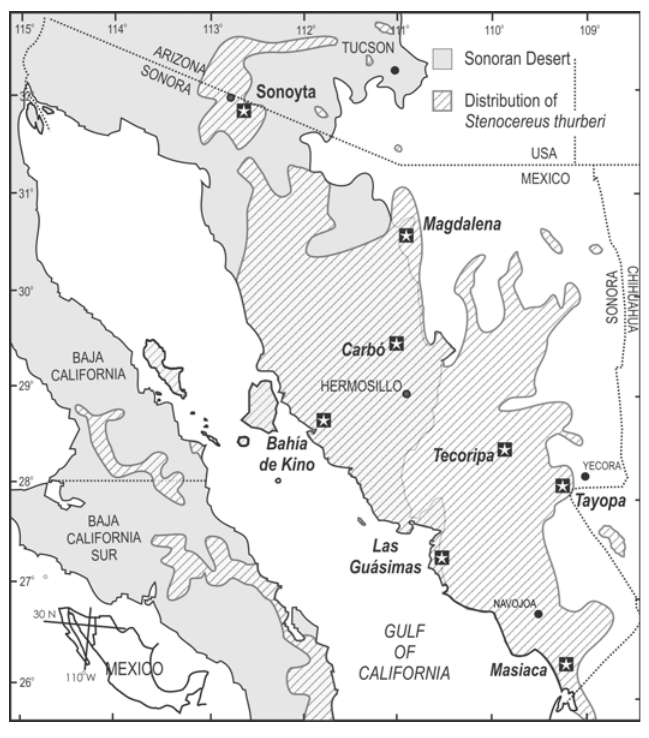
Fig 1. Geographical distribution of Stenocereus thurberi (diagonal lines; modified from Turner et al ., 1995), and location of the eight studied populations (stars). Sonoran Desert extent (gray). doi:10.1371/journal.pone.0152329.g001 were stored in the field in an ice chest. Later that day, these were transferred to a freezer at -19°C before storing in an ultracold freezer (-80°C). DNA extraction DNA extraction was accomplished using mini-preps [50] with some modifications for succu- lents [51]. About 1 g of tissue was ground with liquid nitrogen to a fine powder. Genomic Table 1. Geographic location, elevation and vegetation type of Stenocereus thurberi populations used for genetic analysis in this study. Population N